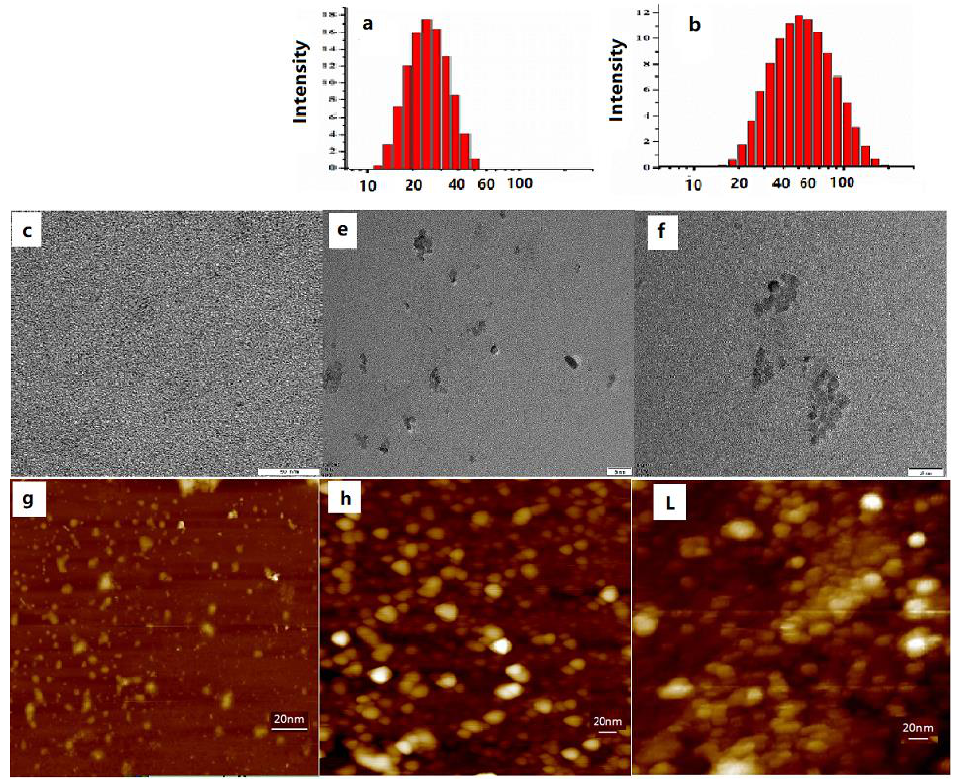
Figure 4. Particle size distribution of ( a )PCBMB-BAPTAVP (1:1) and ( b ) PCBMB-BAPTAVP-Ca